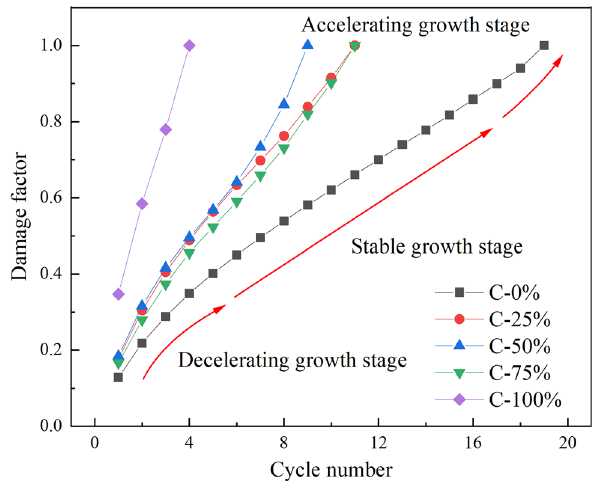
Fig. 12 Damage evolution